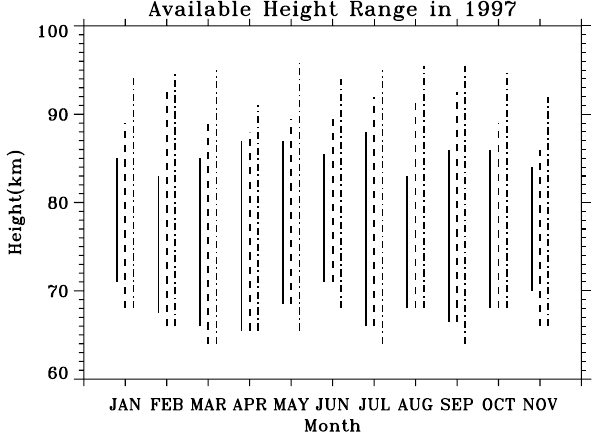
Fig. 4. Radial wind profile with the eastward beam on 16 July 1997. Left : On-line fitting. Right : Improved method (time resolution, 30 minutes).